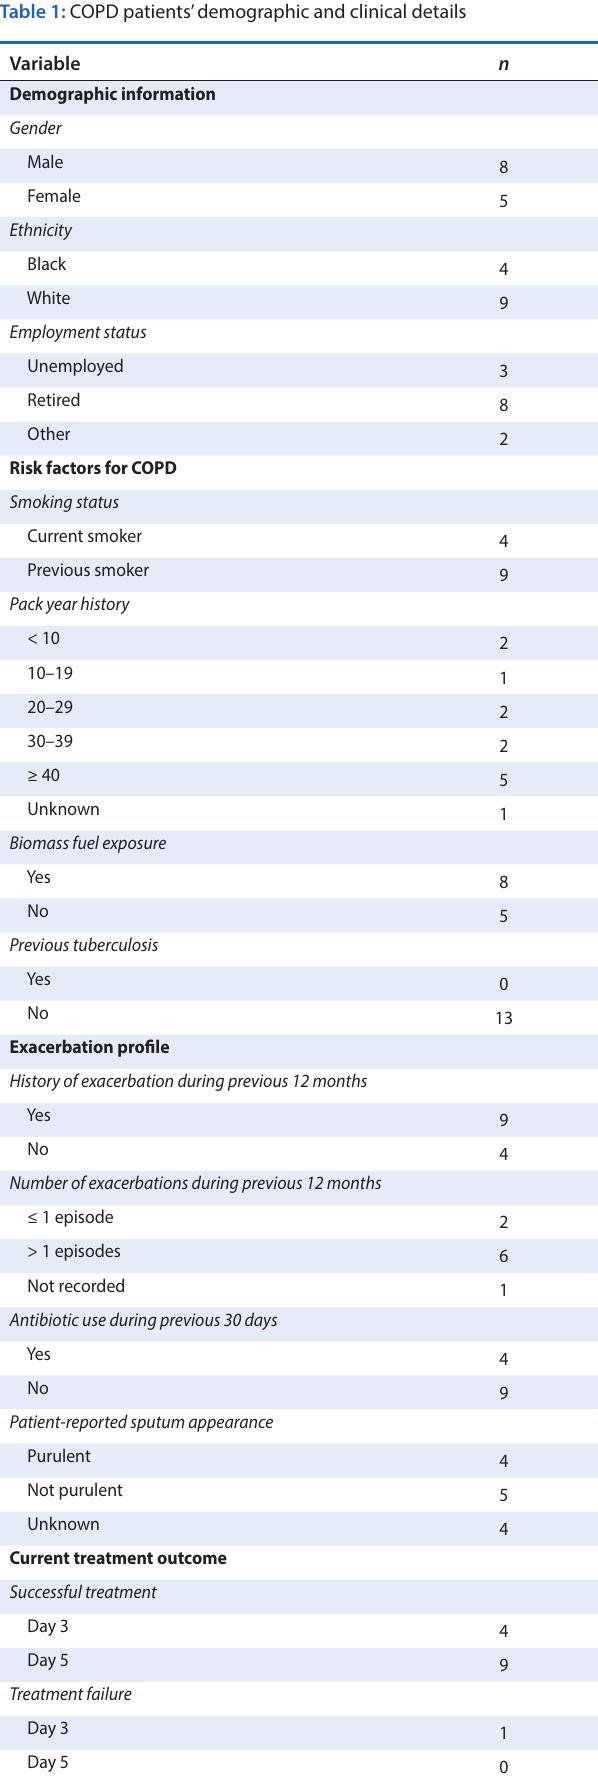
Table 1: COPD patients’ demographic and clinical